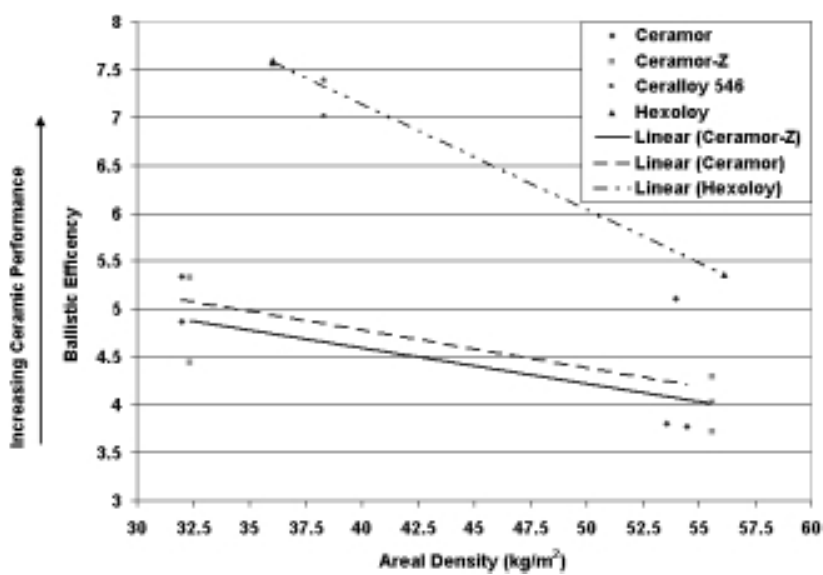
Fig. 8. Ballistic efficiency vs. areal density for 910 m/s